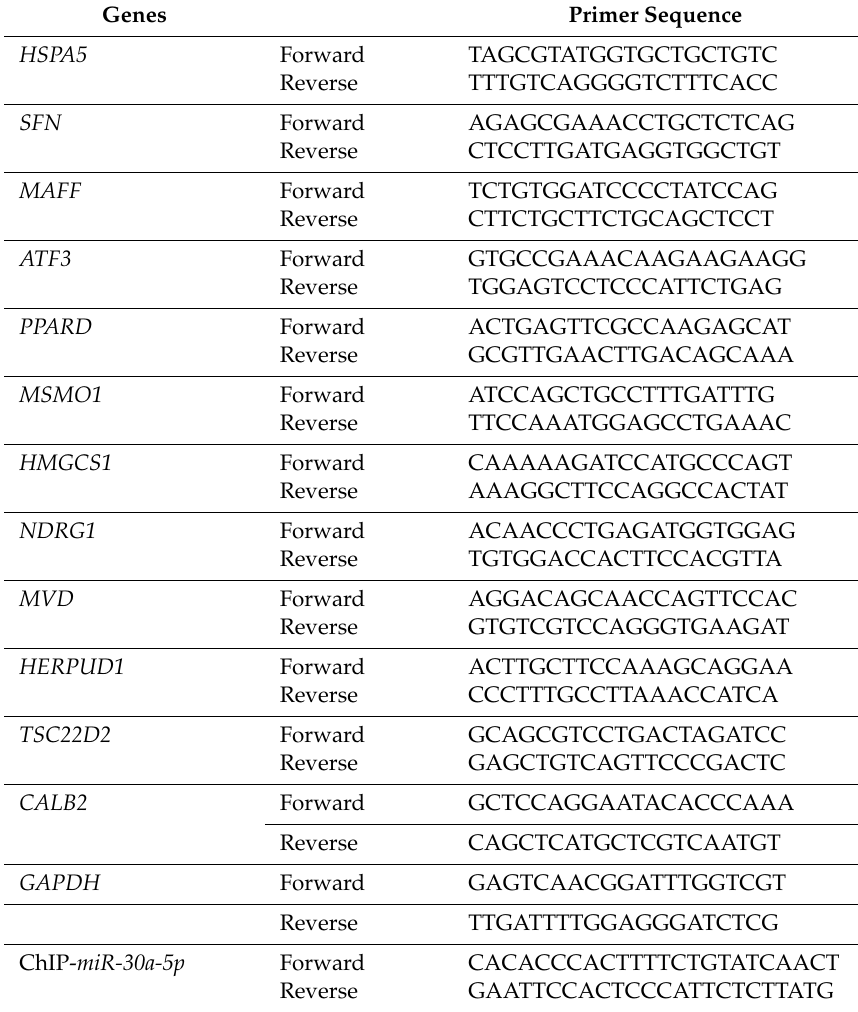
Table 1. Primer sequence for